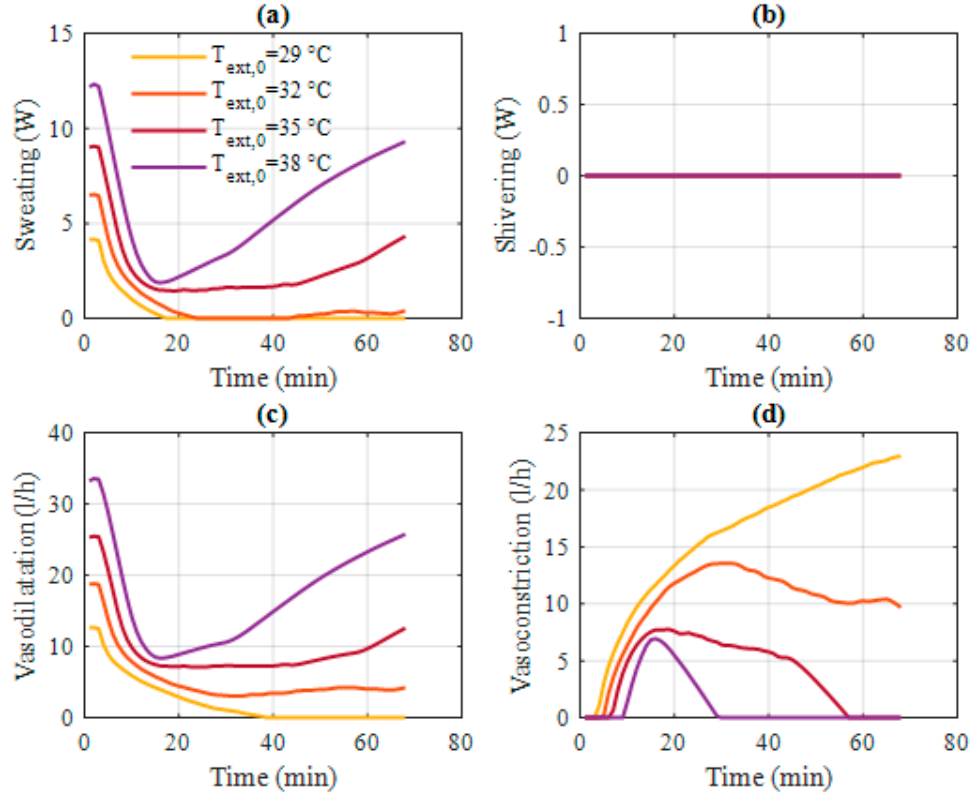
Figure 16. Thermoregulation mechanisms trajectories for a driver dressed in a formal way and different outside temperature profiles: ( a ) Sweating, ( b ) Shivering, ( c ) Vasodilatation, ( d ) Vasoconstriction.